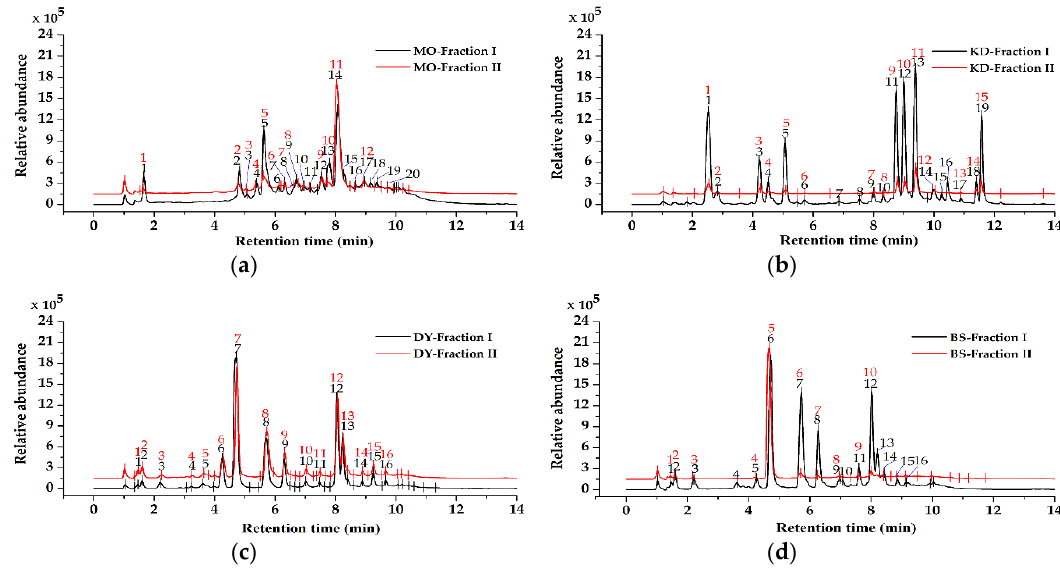
Figure 1. The UPLC-UV-visible chromatogram (270 nm) for the fractions from herbal teas and green teas. ( a ) ( b ) ( c ) ( d ) represent the chromatogram of the two fractions of Mallotus oblongifolius Muell. Arg. (MO), Ilex kudingcha C.J. Tseng (KD), Camellia sinensis var. assamica (J. W. Mast.) Kitam. Hainan Dayezhong (DY) and Camellia sinensis (L.) O. Ktze. (BS), respectively. Table 1. UPLC-PDA-ESI ( − ) -HRMS date and putative identification of flavonoids and phenolic acid derivatives from herbal teas and green teas. Formula Tentatively Identified